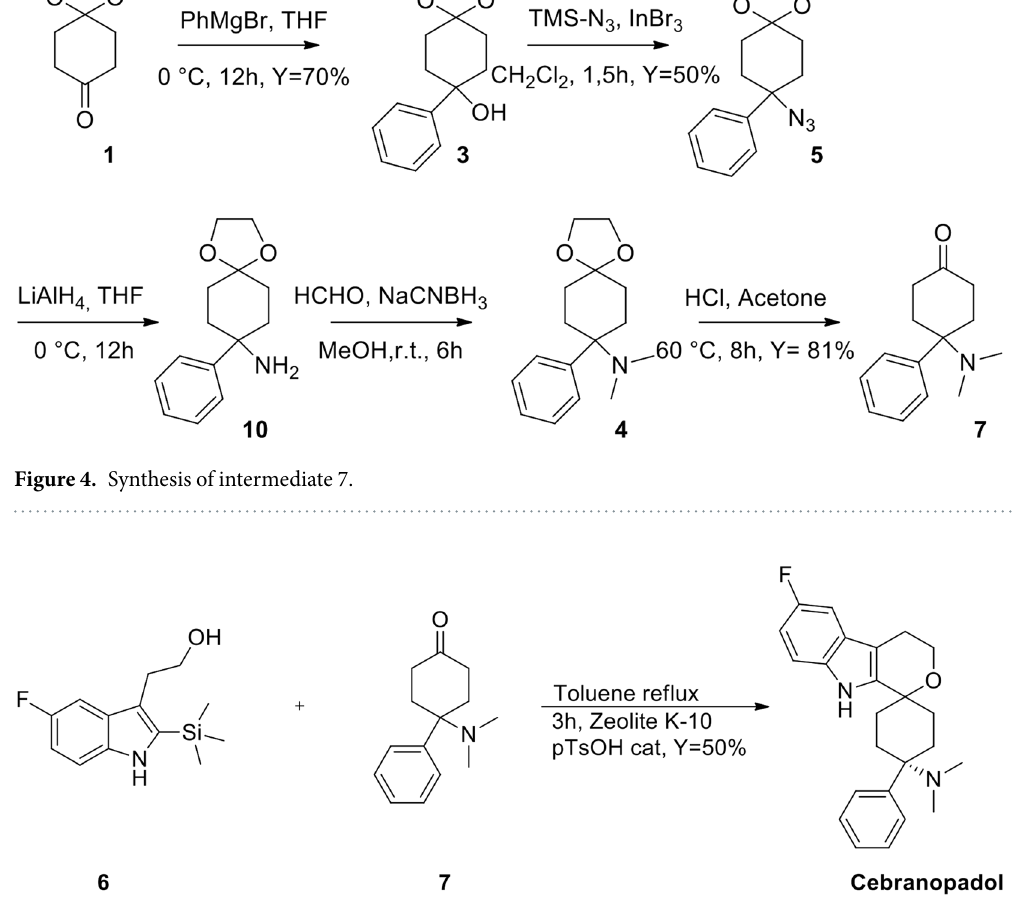
Figure 5. Unusual diastereoselective oxa-Pictet-Spengler